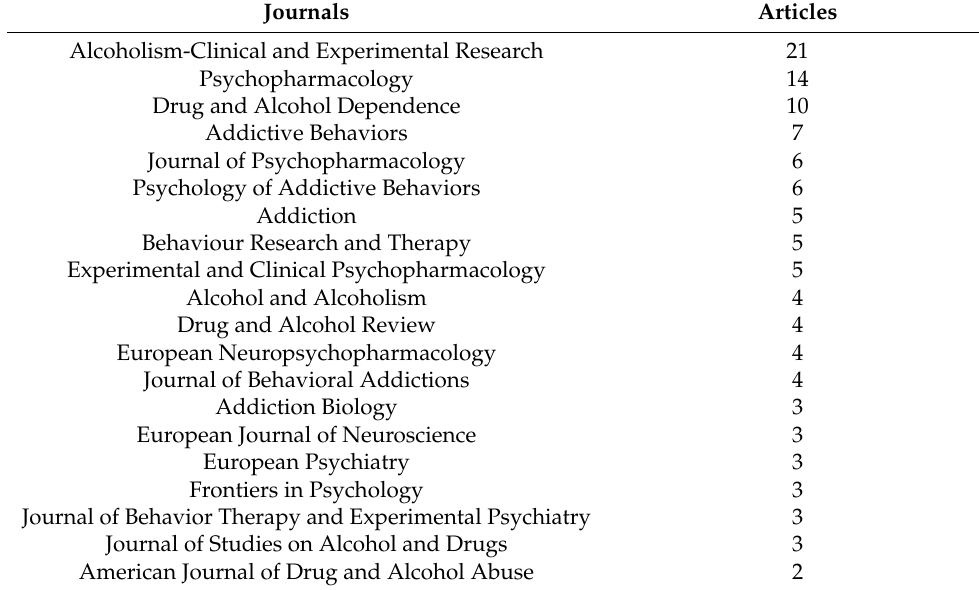
Table 1. Journals in which articles were published.